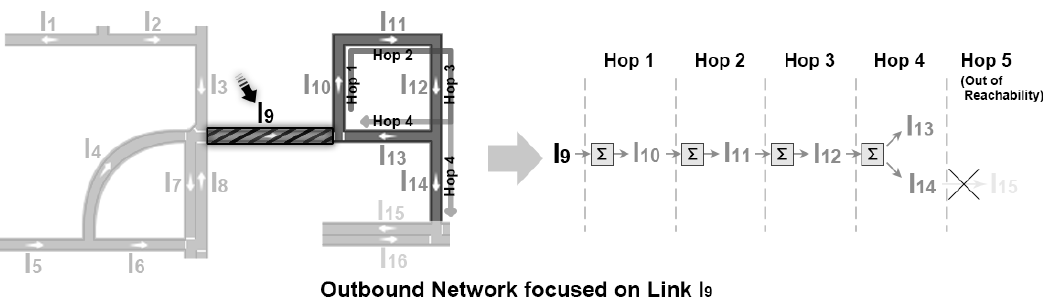
Figure 5. Extraction of outbound reachable paths and the computation of the outbound Z value for I 9